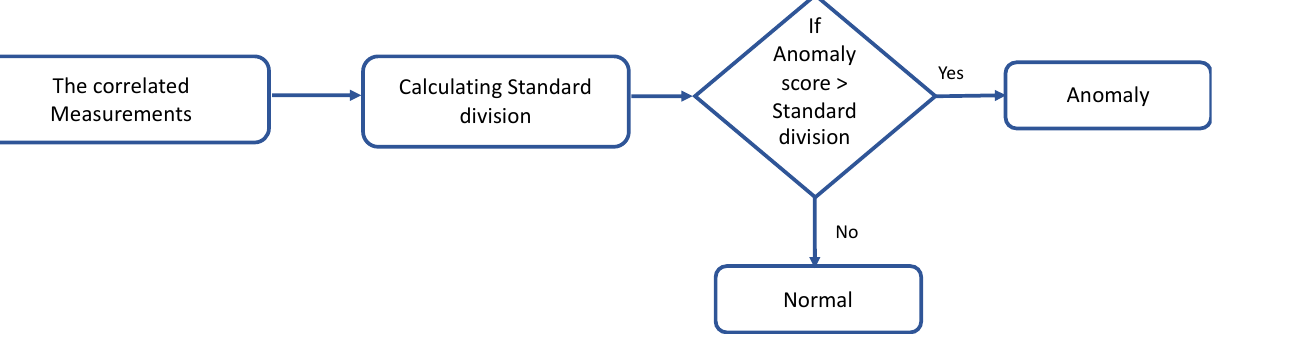
Figure 7. Process of calculation the contextual anomaly.